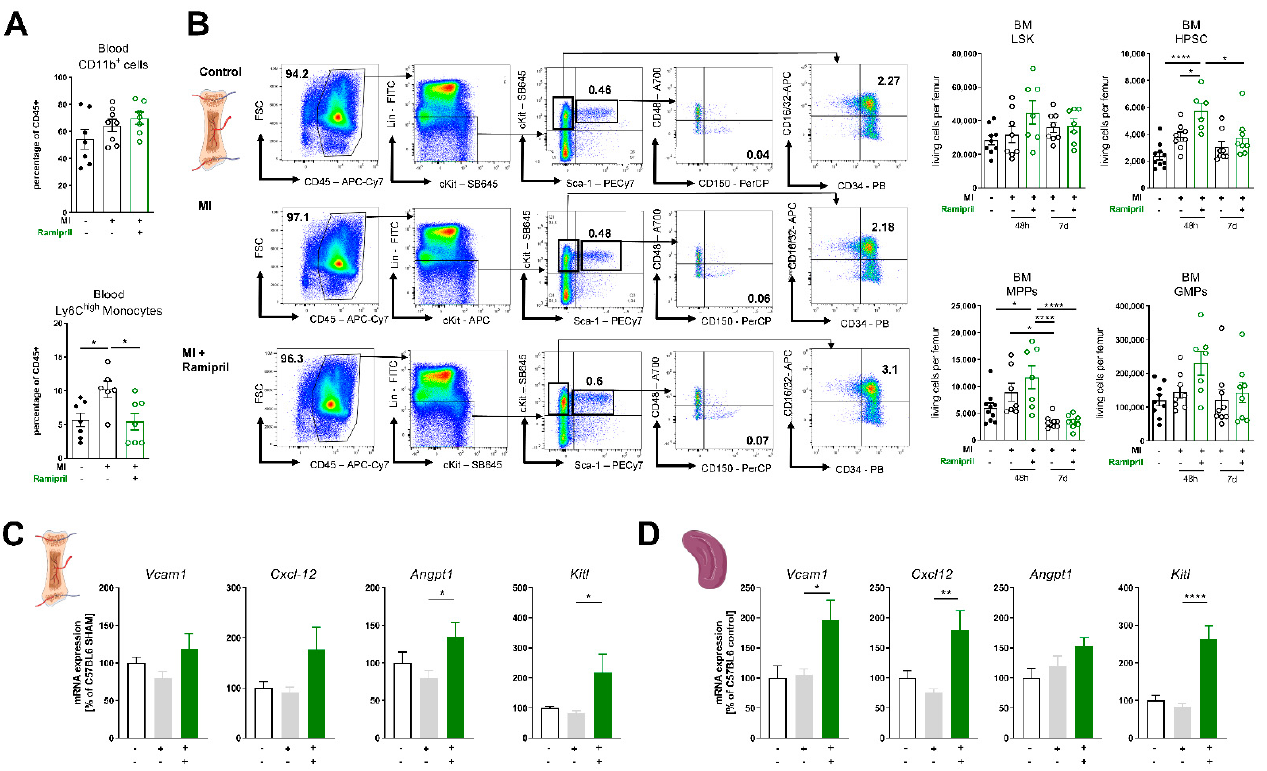
Figure 2. ACE (angiotensin-converting-enzyme) inhibition limits the number of circulating monocytes and retains HPSC (hematopoetic stem cells) due to upregulation of retention factors in the bone marrow and spleen. ( A ) Flow cytometry quantification of circulating CD11b + myeloid cells and Ly6C high monocytes in whole blood 7 days after MI, n = 6–7 mice per group; ( B ) Quantification of LSK, HPSCs, MPPs and GMPs in the bone marrow 48 h and 7 d post-MI; left: representative FACS (fluorescent activated cell sorting) plots; bold numbers indicate percentual ratio of total living cells, right: quantification of Lineage − /Sca1 + /cKit + LSK, Lineage − /Sca1 + /cKit + /CD48 − /CD150 + HPSCs, Lineage − Sca1 − /cKit + /CD48 − /CD150 − MPPs, Lineage − Sca1 − /cKit + /CD16/CD32 + /CD34 + GMPs per femur; n = 7–10, ( C ) + ( D ) mRNA expression of Vcam-1, Cxcl-12, Angpt1 and Kitl in the bone marrow ( C ) and spleen 7 days after MI ( D ), n = 4–8 mice per group; mean + SEM, 1-way-ANOVA or Kruskal–Wallis test with Dunn’s multiple comparisons test. * p < 0.05, ** p < 0.01, **** p < 0.0001.